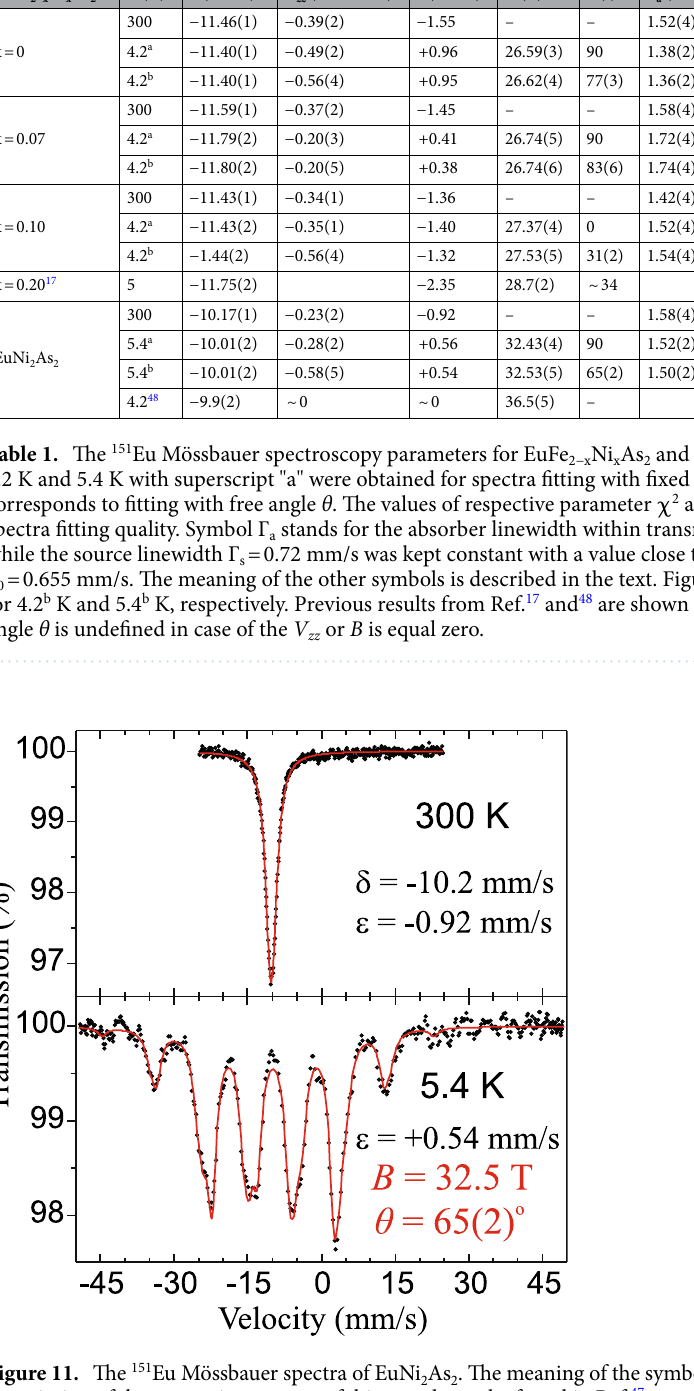
Figure 11. The 151 Eu Mössbauer spectra of EuNi 2 As 2 . The meaning of the symbols is the same as in Fig. 10. Description of the magnetic structure of this sample can be found in Ref. 47